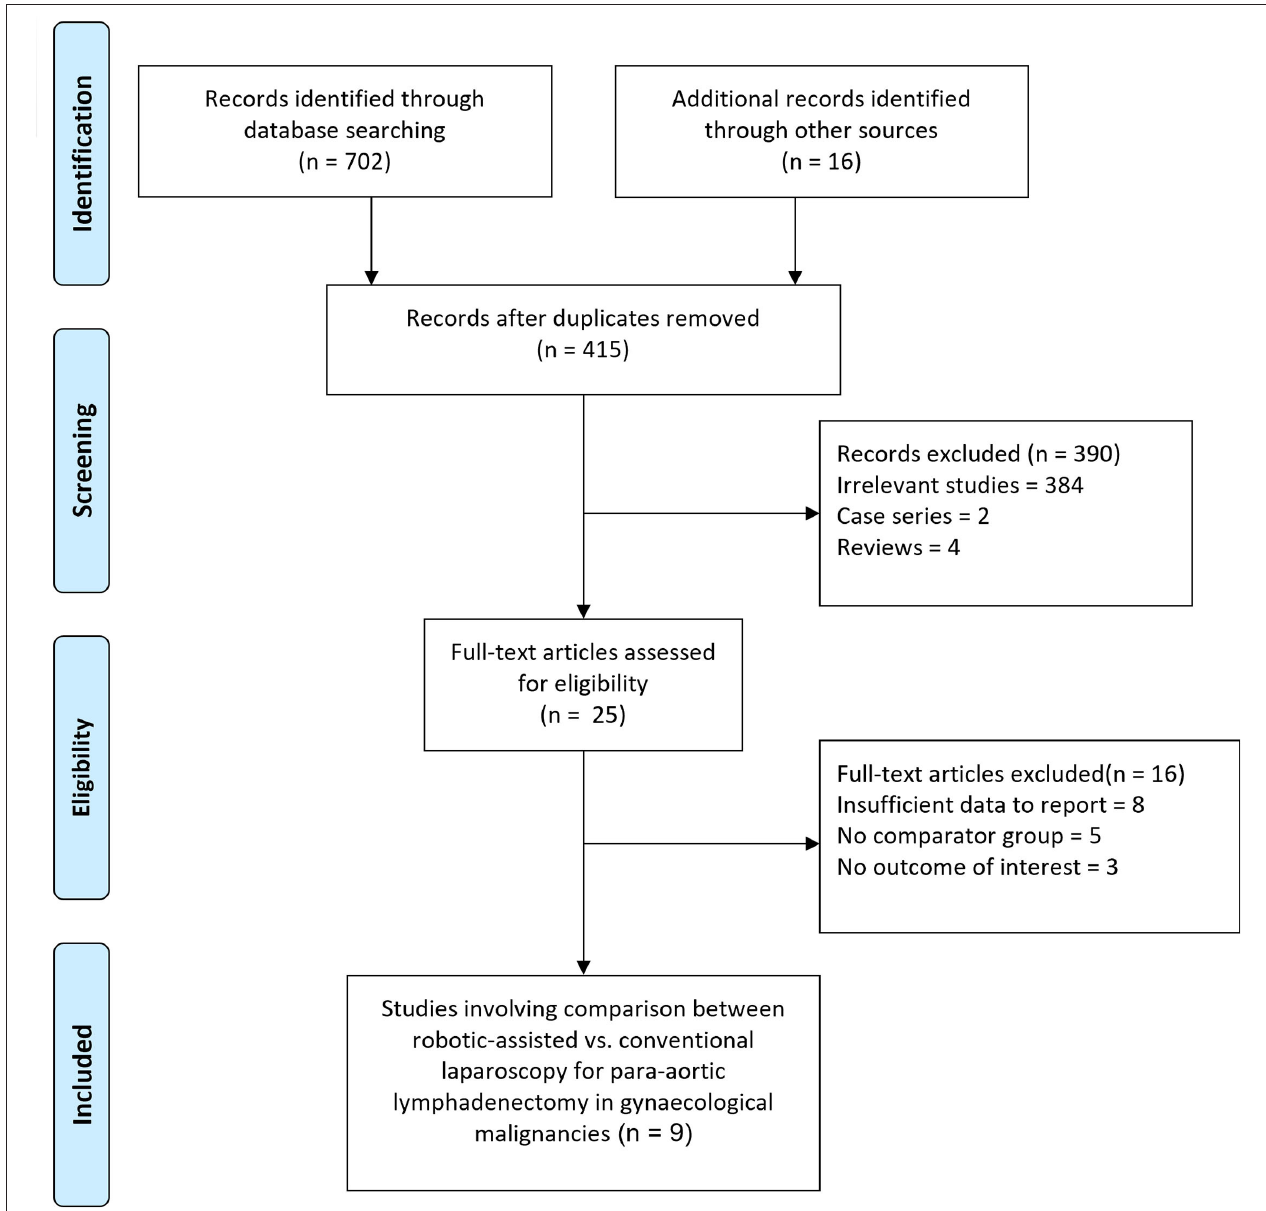
FIGURE 1 | Flow diagram for the selection of studies and specific reasons for exclusion from the present